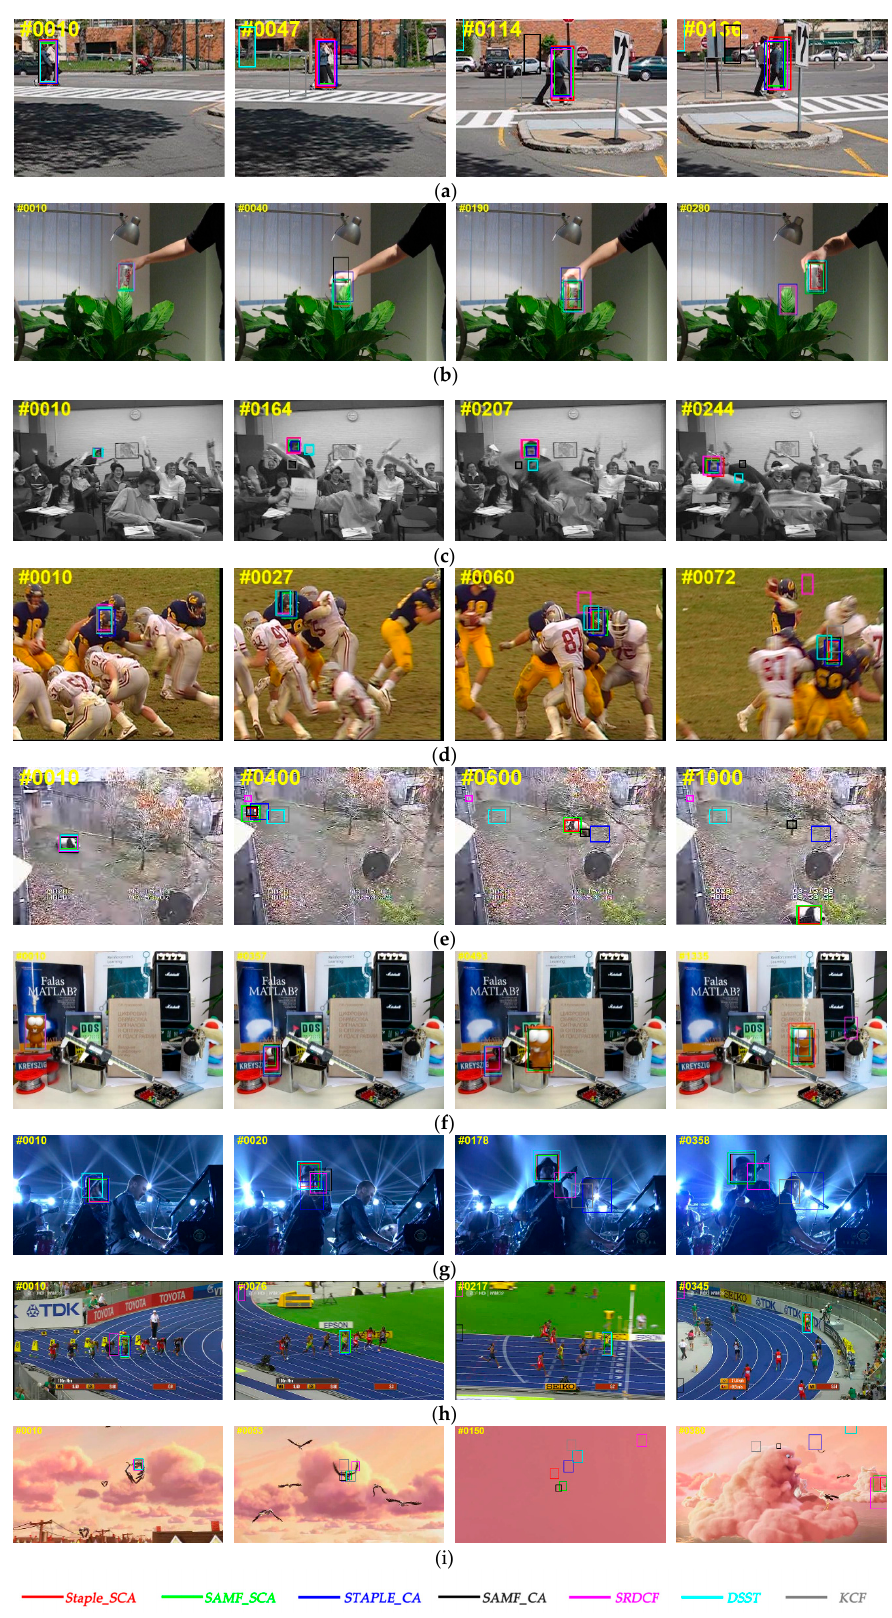
Figure 6. Comparison of our trackers with other State-of-art trackers [15,17,19,20] in different challenging situations. ( a ) couple; ( b ) coke; ( c ) freeman4; ( d ) football1; ( e ) Panda; ( f ) lemming; ( g ) shaking; ( h ) bolt; ( i ) Bird1.